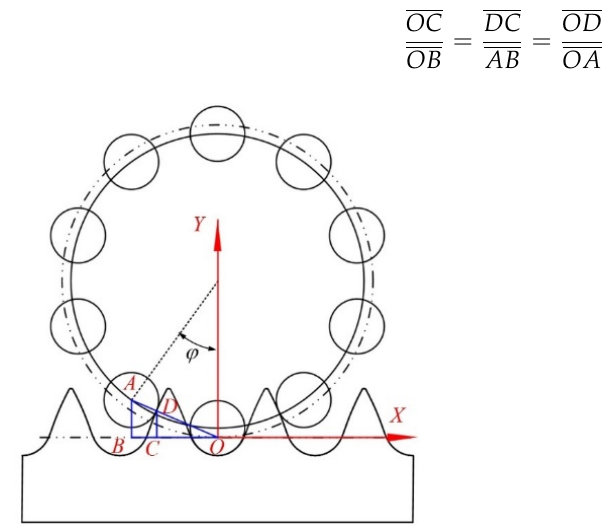
Figure 5. Schematic diagram of meshing point of trochoid roller pinion rack.